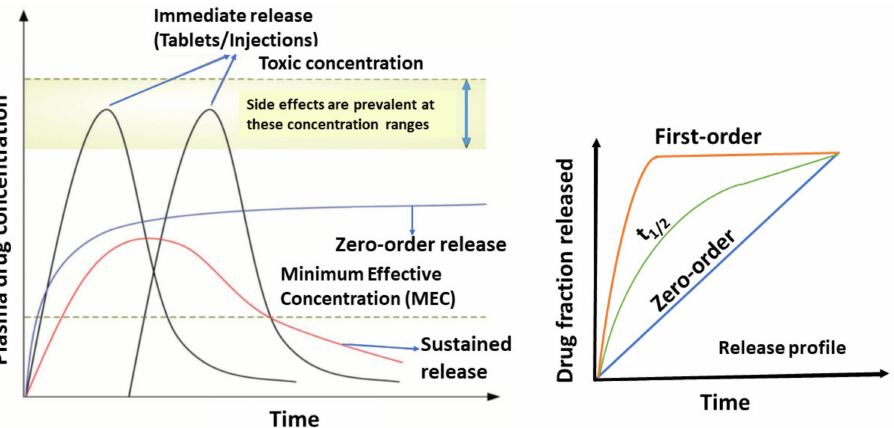
Figure 16. Drug plasma levels and release